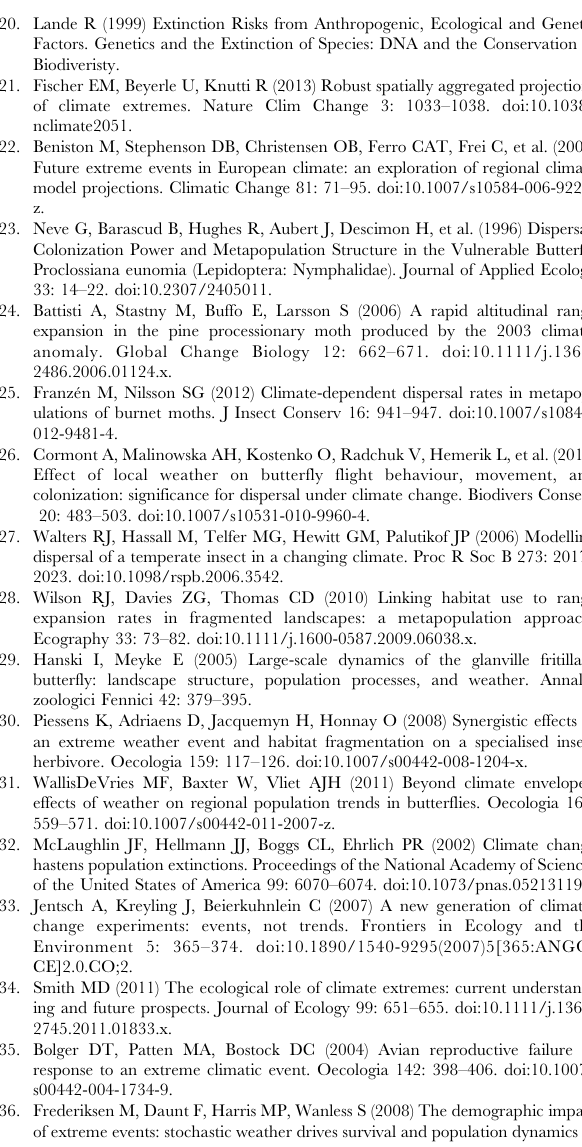
Table S7 Relationship between persistence and